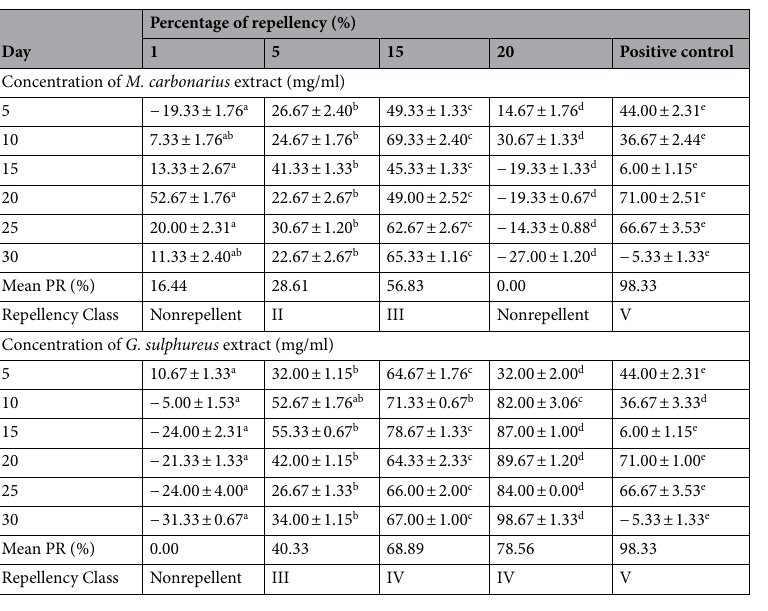
Table 3. Mean percentage repellency with the standard error and repellency class of Macrotermes carbonarius and Globitermes sulphureus extracts against Periplaneta americana . Different letters in the same row indicate a significant difference ( p < 0.05, Duncan’s test). Mean PR = mean percentage of repellency. Mean of three replicates (n = 30 termites per replicate). Repellency class = class 0 (> 0.01 to < 0.1%), nonrepellent; class I (0.1–20%), very weakly repellent; class II (20.1–40%), moderately repellent; class III (40.1–60%), averagely repellency; class IV (60.1–80%), fairly repellent; class V (80.1–100%), very repellent.